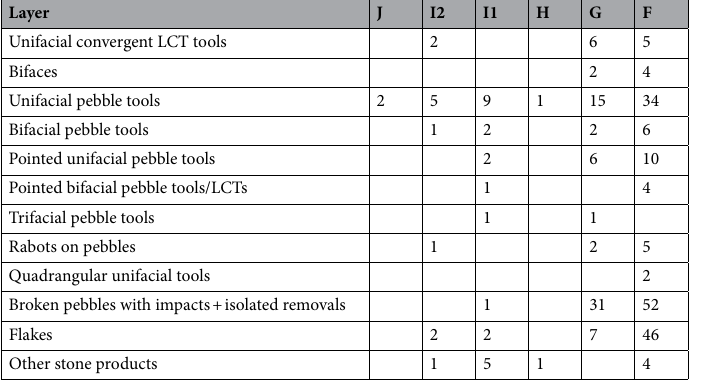
Table 2. Heavy-duty component on limestone pebbles per archaeological layer (number) and flakes in other stones.